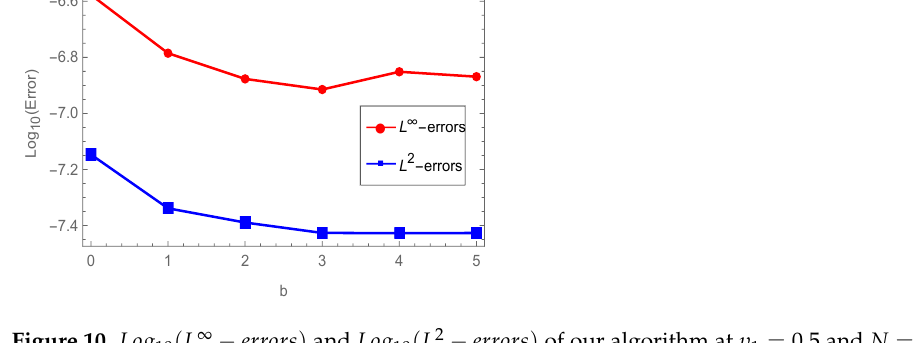
Figure 10. Log 10 ( L ∞ − errors ) and Log 10 ( L 2 − errors ) of our algorithm at υ 1 = 0.5 and N = 20 with distinct b for Example 4.